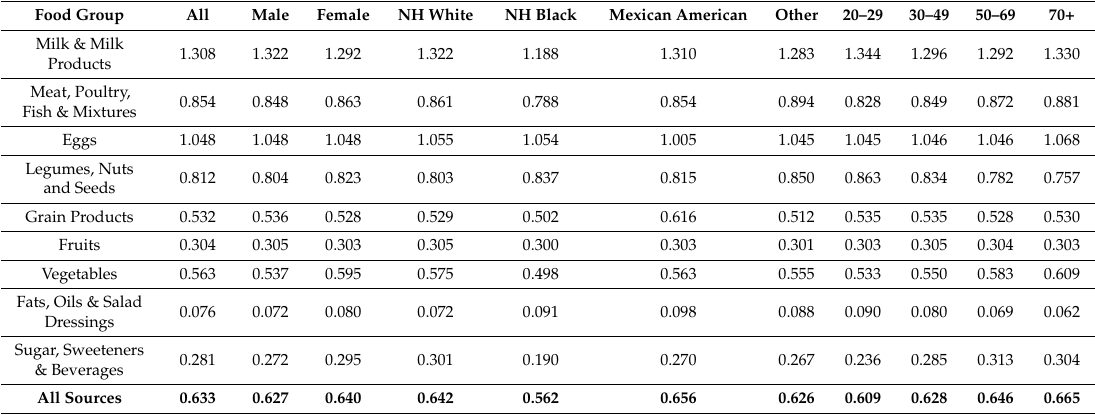
Table 4. Estimated dietary phosphorus density (mg phosphorus/kcal) by USDA food group in NHANES WWEIA 2001–2014 in adults 20 years of age or